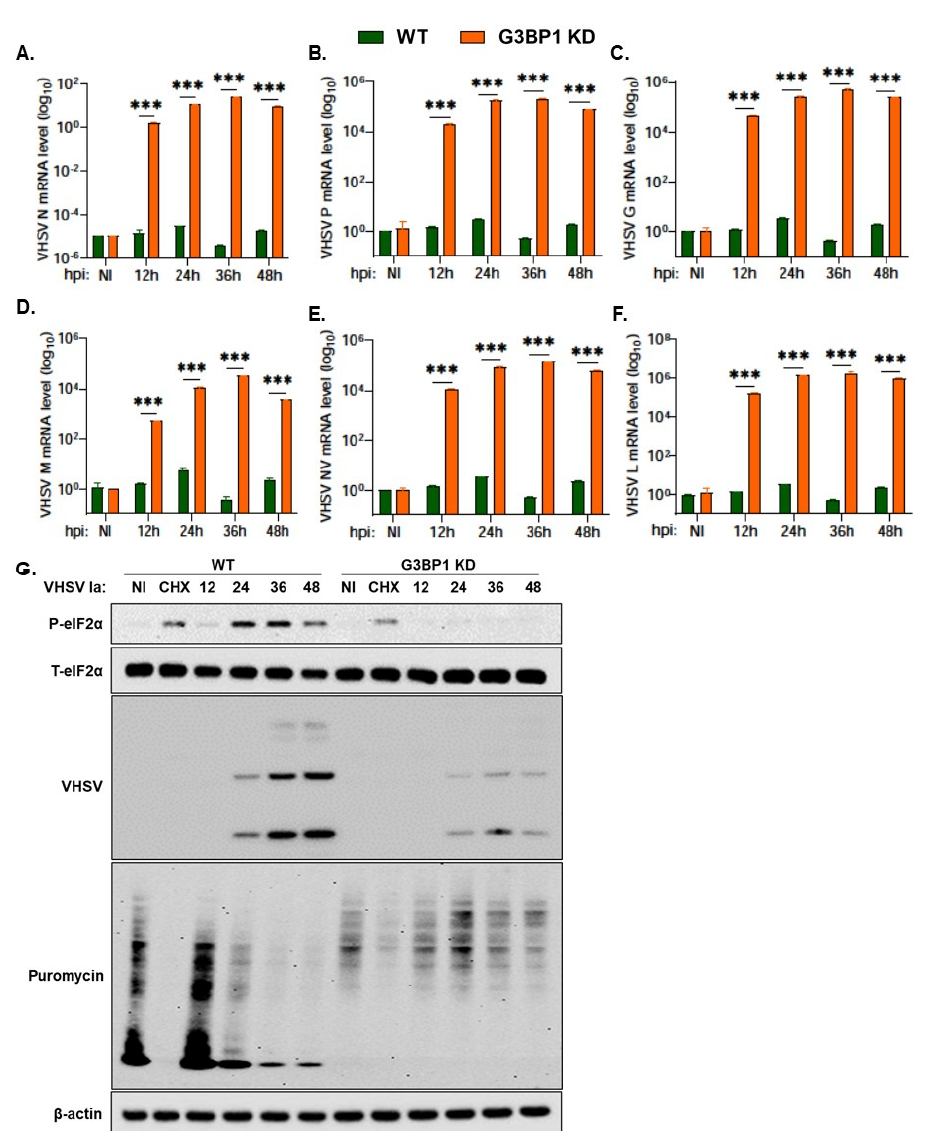
Figure 7. G3BP1 is required for viral protein expression. WT and G3BP1 KD cells were infected with VHSV Ia for indicated times at MOI = 1 and mRNA levels of ( A ) VHSV N, ( B ) VHSV P, ( C ) VHSV G, ( D ) VHSV M, ( E ) VHSV NV and ( F ) VHSV L was measured by qRT-PCR and normalized to spiked internal control and presented as fold change in expression compared to no treatment. ( G ) WT and G3BP1 KD cells were infected with VHSV Ia at MOI of 1. At indicated time points, cells were pulsed with puromycin (10 μ g/mL) for 20 min and cell lysates were analyzed by immunoblotting using antibodies against p-eIF2 α , T-eIF2 α , puromycin and viral proteins were detected using VHSV antibodies. β -actin was used as loading control. Data are representative from two individual experiments. The data represent mean ± SD; WT: wildtype; KD: knockdown; NI: not infected; CHX: cycloheximide. ***, p < 0.001.